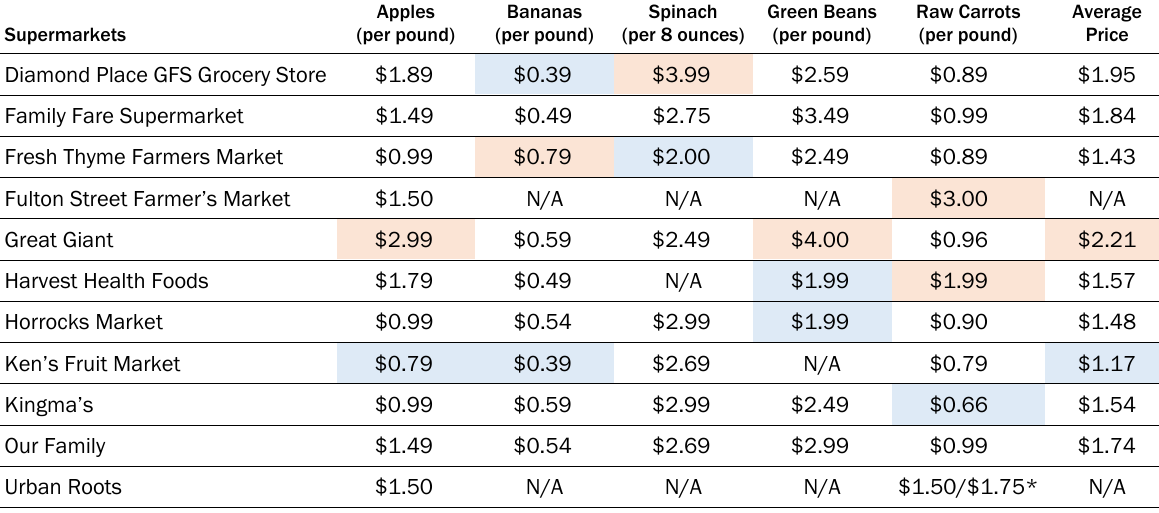
Table 1. Supermarket Prices of Common Produce Items Selected Comparative average prices not noted if more than 3 unavailable items. Pink shading denotes highest prices, while blue shading denotes lowest prices by